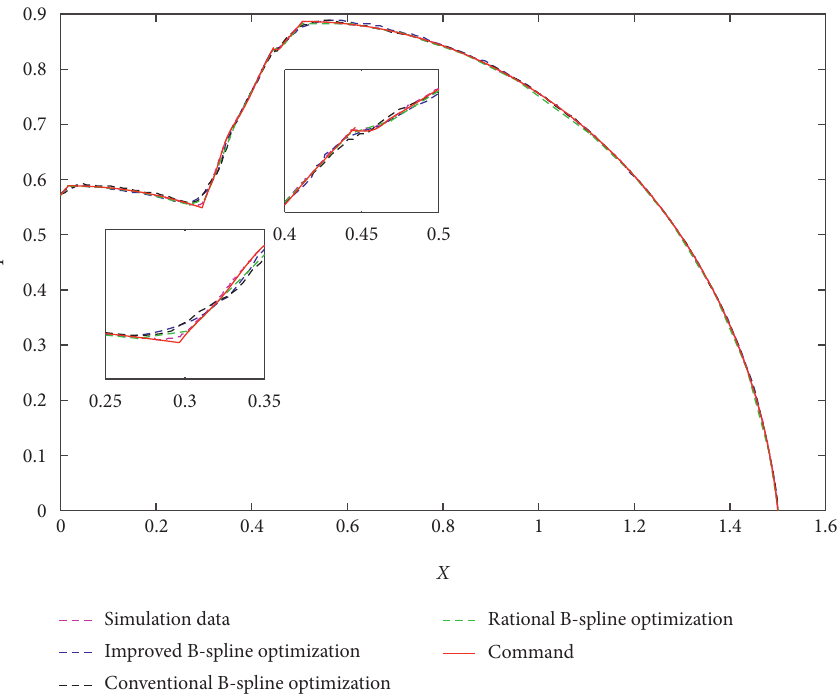
Figure 12: Comparison of simulation results in